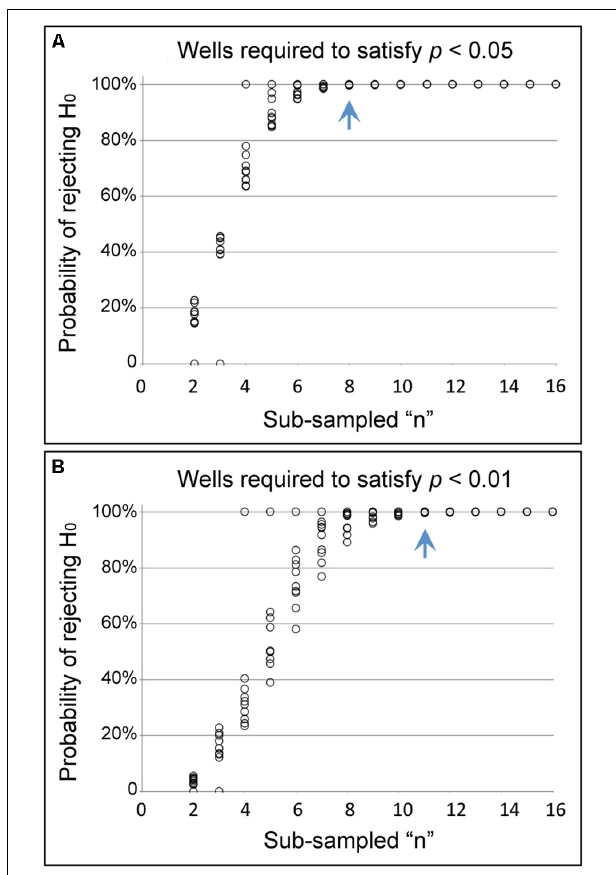
FIGURE 4 | Identifying sufficient sample size in the pate assay format. The graphs show the likelihood of seeing a significant difference in hatch rate between CI and CI+NaBu conditions, as defined by (A) the conventional α -value of 0.05, as well as (B) the more stringent α -value of 0.01. The blue arrow indicates the number of wells at which the probability of rejecting the null hypothesis has reached 99.5% or higher for all sub-sampled datasets analyzed.